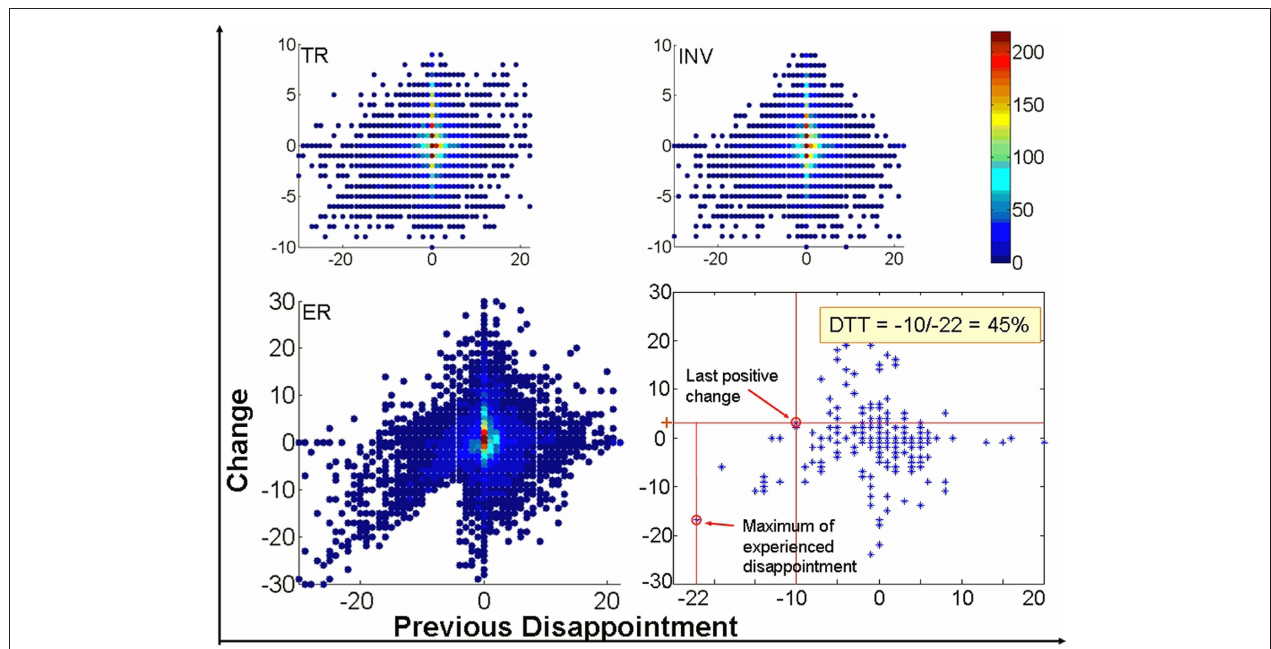
disappointment (most negative values in the abscissa) to be expected if each new Trustee were assessed independently of previous outcome with a completely different Trustee. Disappointment Tolerance Threshold (DTT, the rightmost lower inset) is defined for each participant as the x -value at which the last positive change in ER is observed ( y -axis) divided by the maximum disappointment experienced. For example here, the DTT of the individual subject is: − 10/ − 22 = 0.45 or